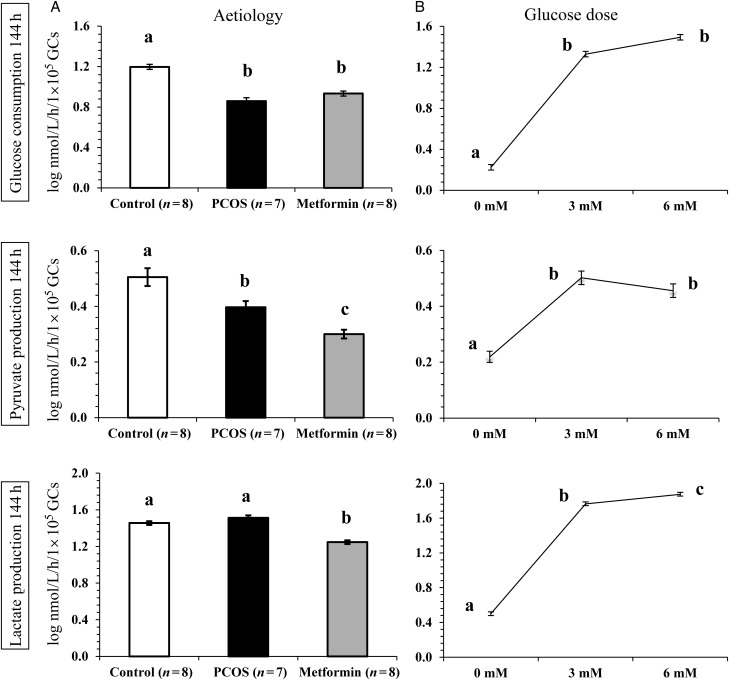
The effect of aetiology (A) and glucose dose in the culture medium (B) on glucose consumption, pyruvate and lactate production by GCs after 144 h of culture. The values are mean ± SEM of the log-transformed data for the number of individual patient cultures shown. Data have been standardized according to viable cell number measured after 144 h of culture. Different letters on the graphs indicate significant differences (P < 0.05) between the three aetiological groups and the glucose doses tested for each metabolite.